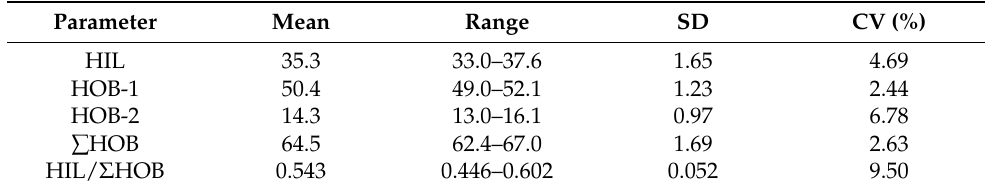
Table 7. Share of hydrophilic and hydrophobic fractions of humic acids isolated from spent mush- room